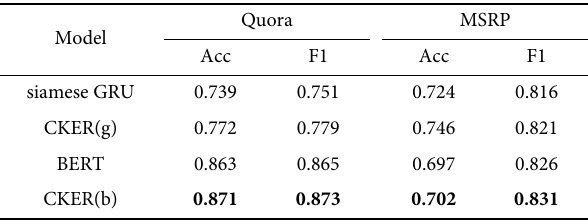
Table 2 Performance after adding CK-Encoder into model. CKER(g) uses GRU as the Sentence Encoder. CKER(b) uses BERT as the Sentence Encoder. Acc represents accuracy.